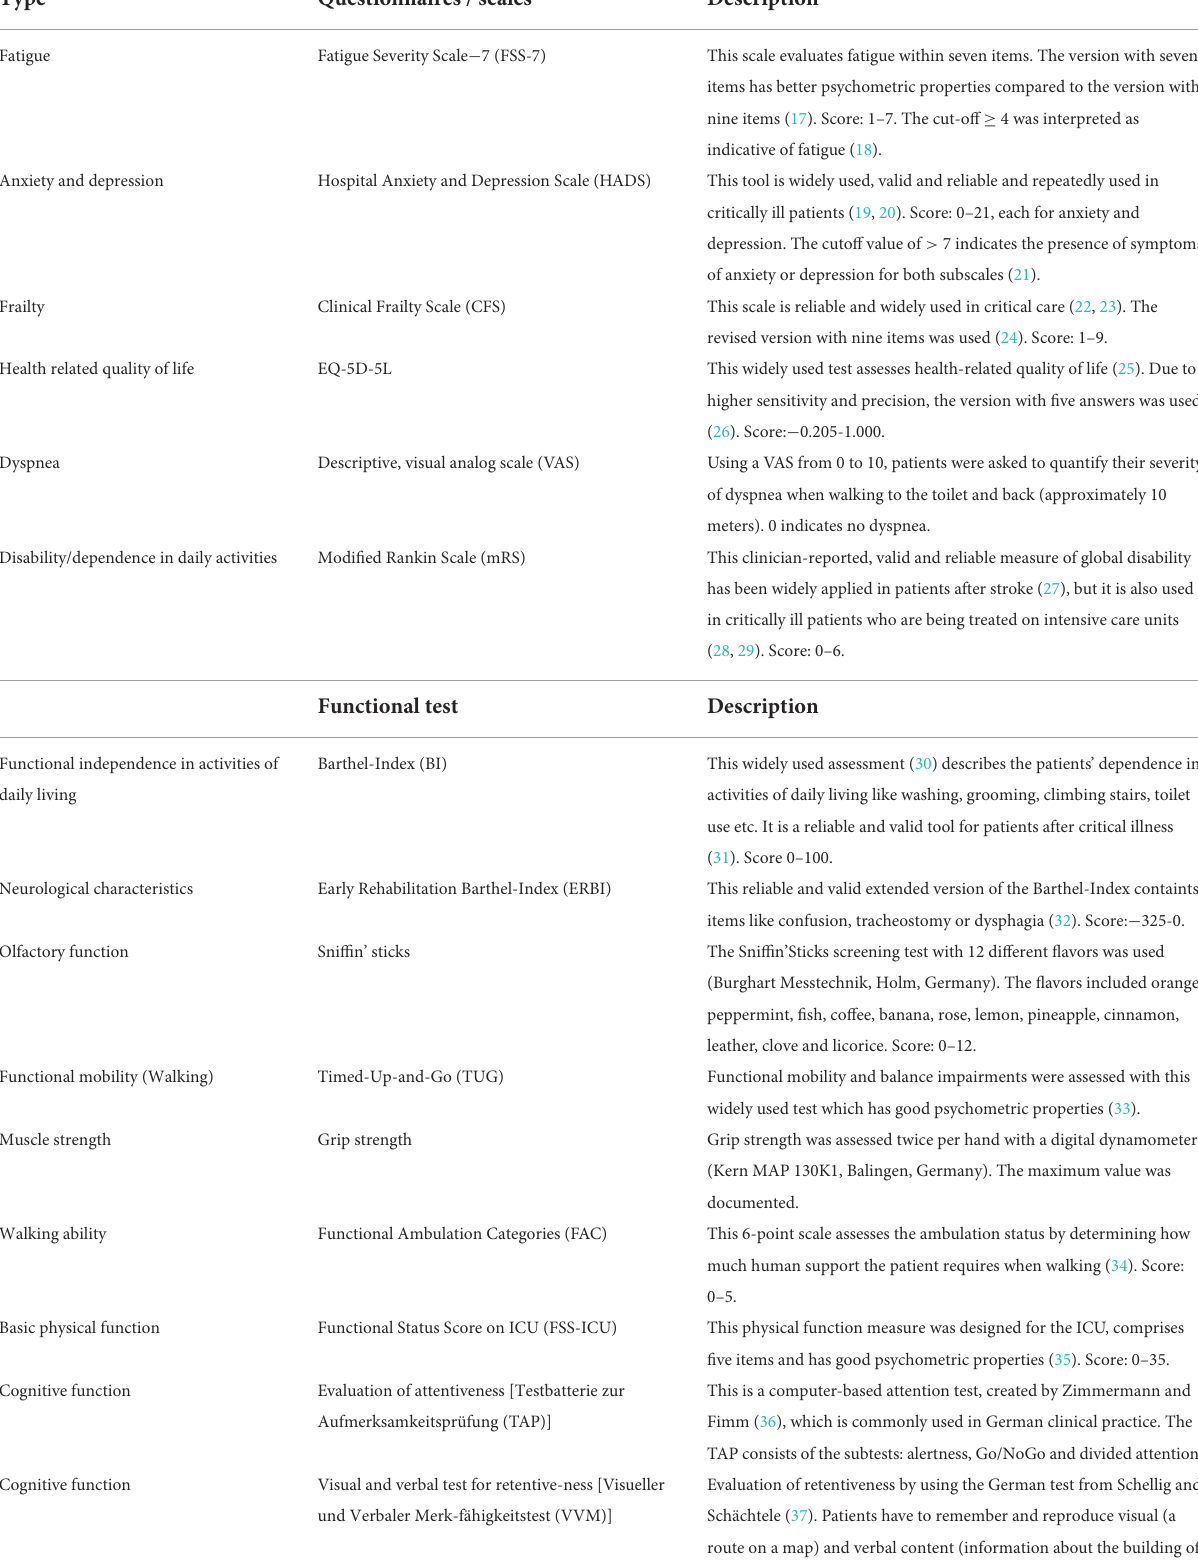
TABLE 1 Overview of questionnaires and functional tests